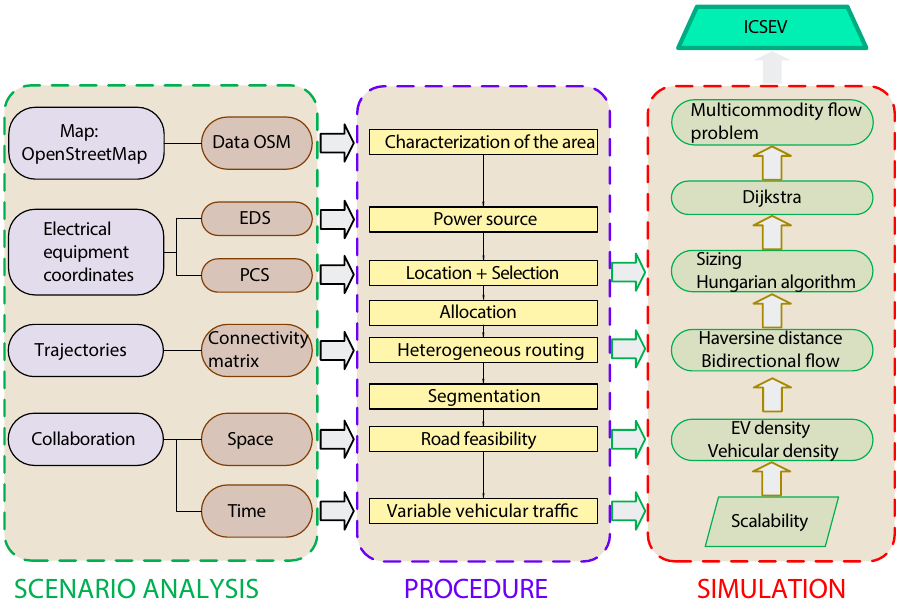
Figure 2. Methodological flowchart for the construction of